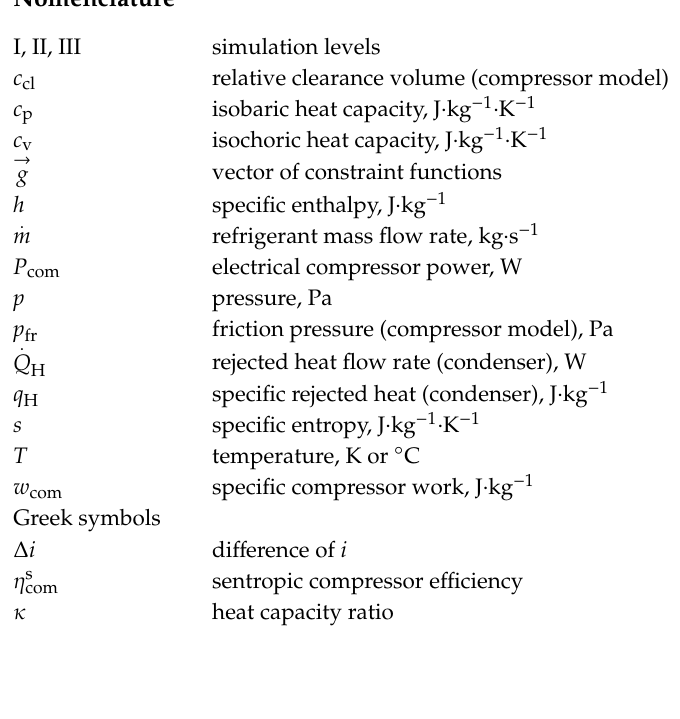
Table S1: Data of dimethyl ether, isobutane and propane. Table S2: Data of propene, R134a and R152a. These tables provide the values of all discussed process parameters for all simulation levels and for the experiments. Italic letters indicate input values of the simulations and regular letters specify